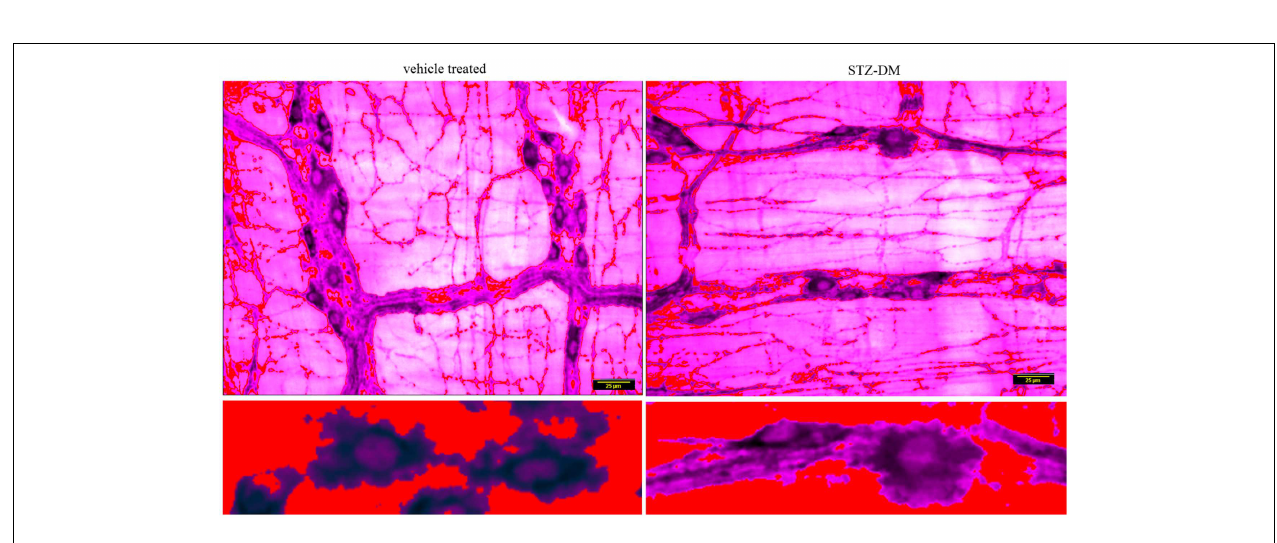
the proximal processes of the nitrergic neurons in both wild type and diabetic jejunal tissues. Renyi entropy type thresholding of pseudocolored images were used to observe the neuronal branch pattern morphology. Scale bar, 25 µ m.